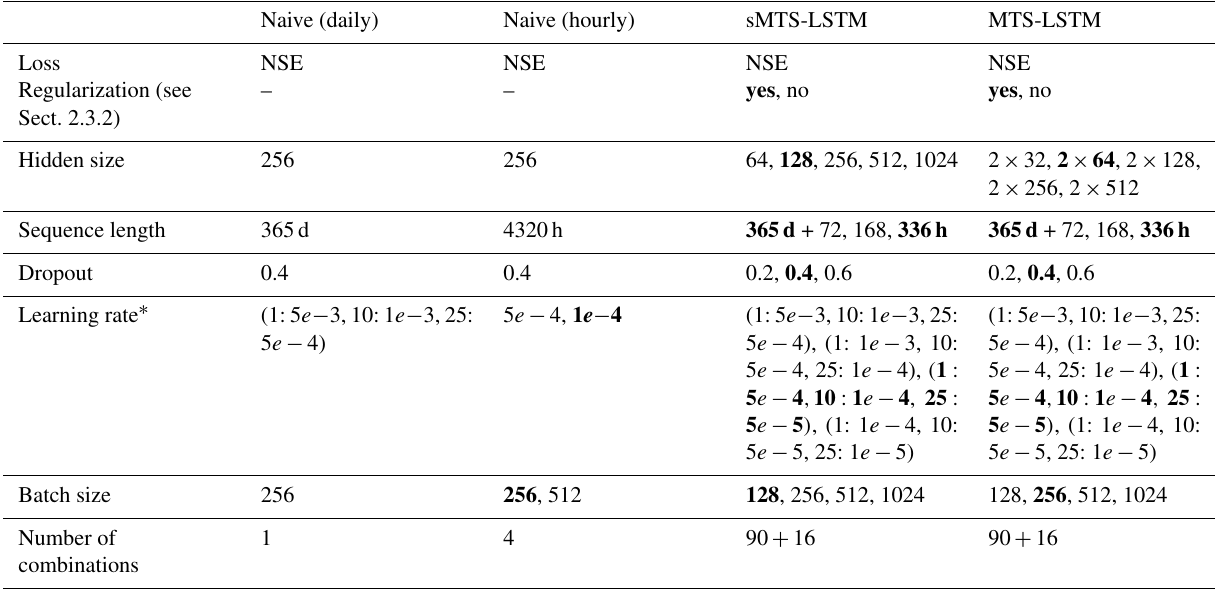
Table D1. Hyperparameter tuning grid. The upper table section lists the architectural parameters tuned in stage one, the lower section lists the parameters tuned in stage two. In both stages, we trained three seeds for each parameter combination and averaged their NSEs. Bold values denote the best hyperparameter combination for each model. Naive (daily) Naive (hourly)